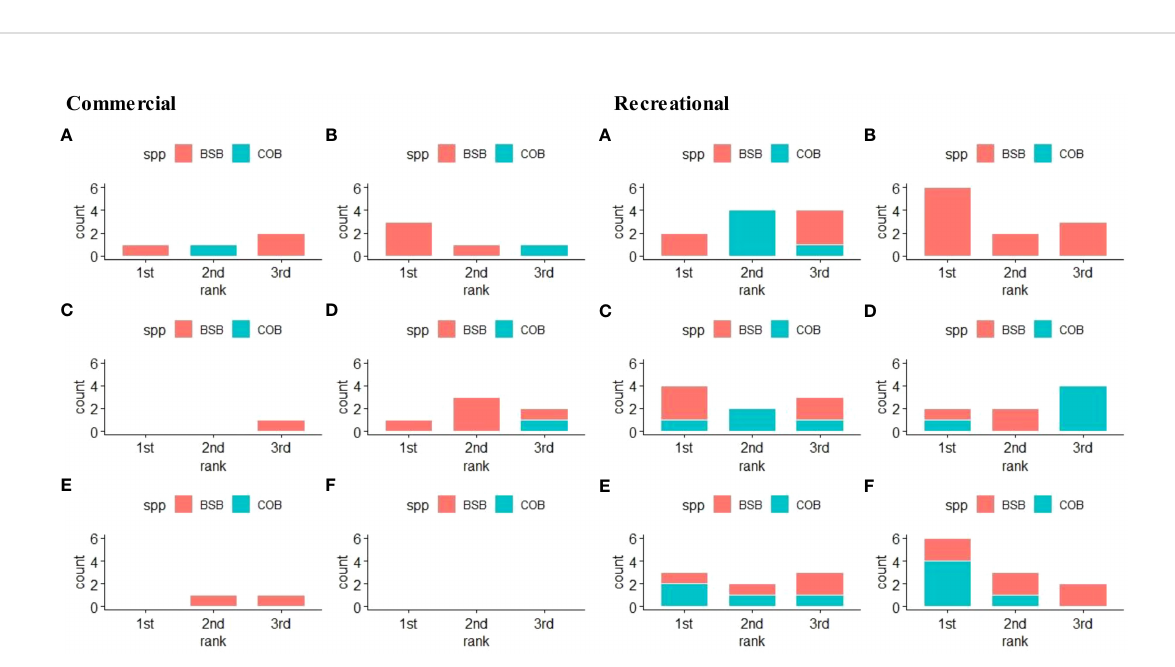
FIGURE 2 Tallied responses to Interview Question 3 which asks fi shers to identify their top three management measures from a list provided by the interviewer. Management measures were ranked 1st, 2nd, or 3rd by commercial fi shers (left) and recreational fi shers (right) for black sea bass (red) and cobia (blue). Options for ranking were (A) “ Changing the vessel/trip or bag limits, ” (B) “ Changing the size limits, ” (C) “ Changing the size limits to a slot limit, ” (D) “ Seasonal closures, ” (E) “ In-season adjustments to vessel/trip or bag limits, ” and (F) “ Changing catch limit allocation among sectors. ”